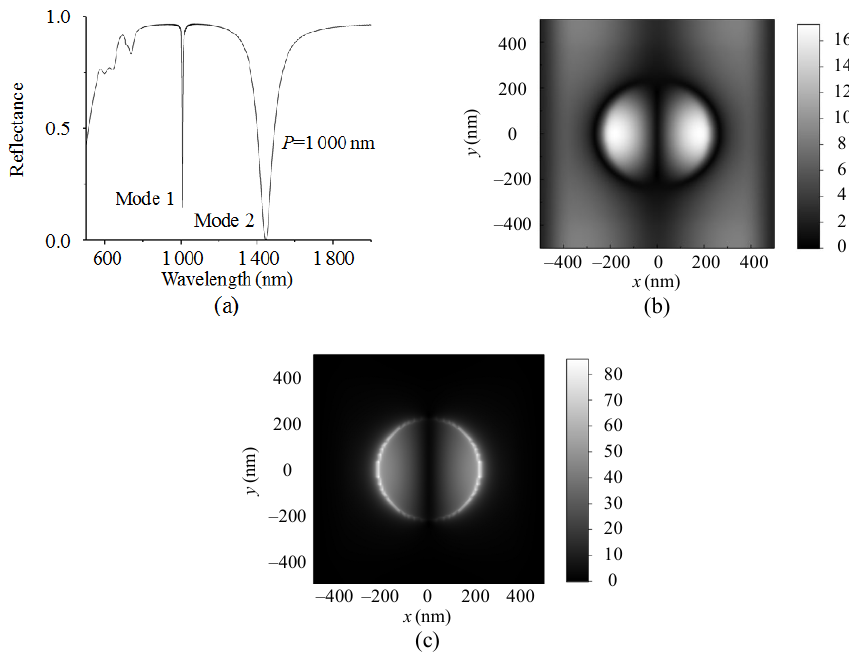
Fig. 8 Plasmonic responses of the 2D grating composite structure: (a) reflection spectrum of the 2D grating composite structure with a period of 1 000 nm, electric field distribution | E | / | E 0 | at the resonance wavelengths of (b) Mode 1 and (c) Mode